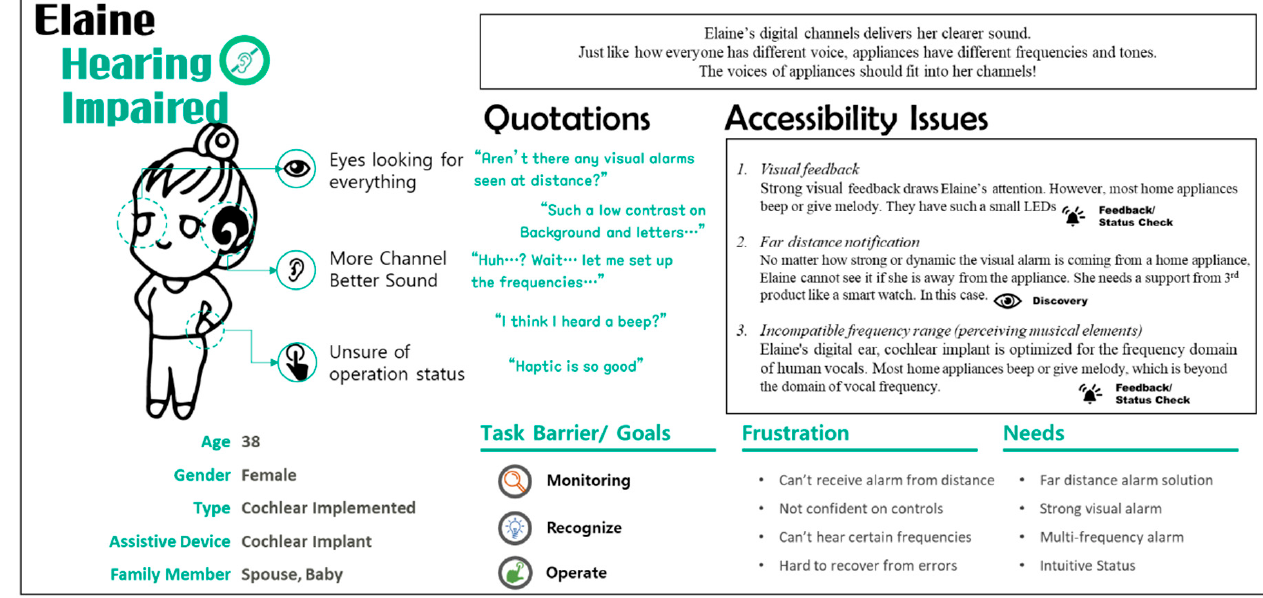
Figure A4. Persona card of Elaine, the cochlear-implemented